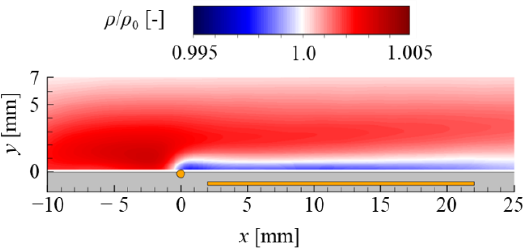
Figure 15. Density field of the wire-PA.